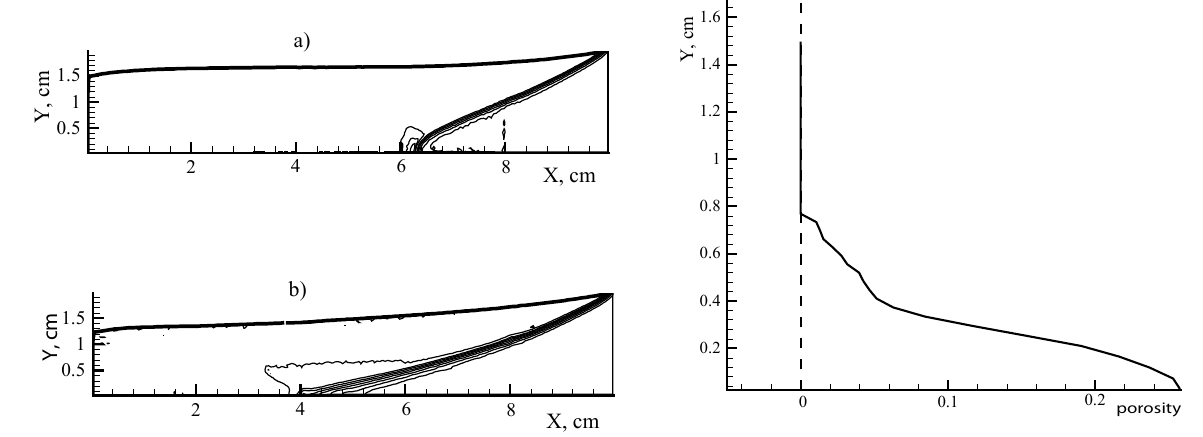
 cm: a) cylindrical e